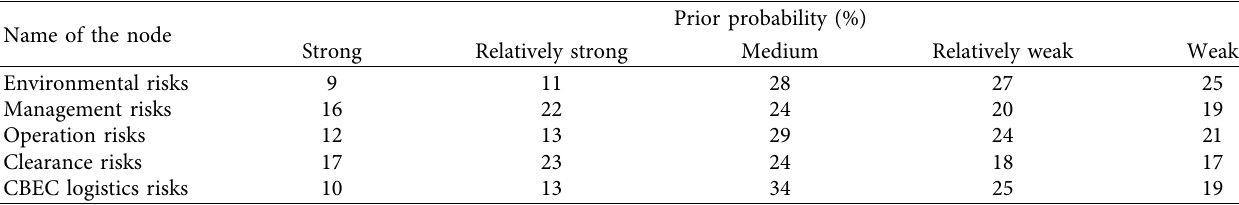
Table 2: Value assignment to destination nodes.